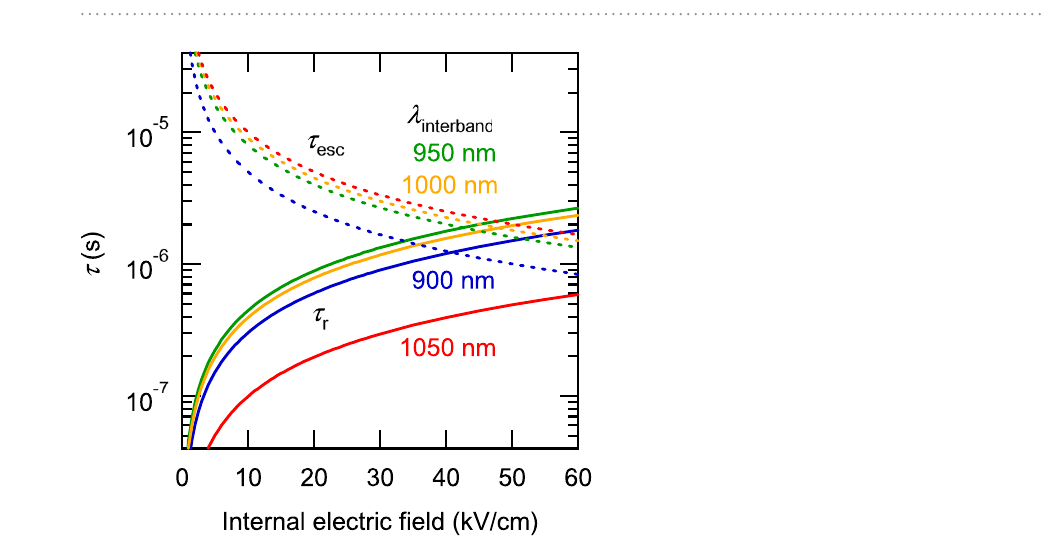
Table 1. Evaluated absorption coefficients in the QDSL.